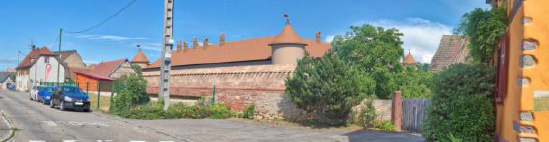
Figure 10d. Castle insertion – Extract of panoramic view (Rue des Écoles)